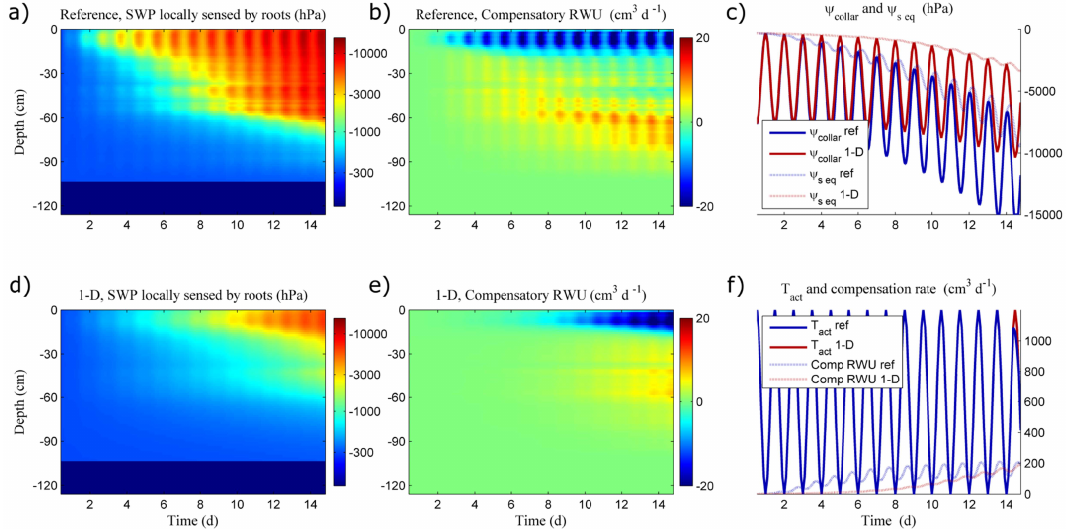
Fig. 7. Spatio-temporal distribution of (a, d) SWP locally sensed by roots and (b, e) compensatory RWU rates (spatial integration of positive terms), respectively in reference and 1-D scenarios. Temporal evolution of (c) plant collar water potential and SWP sensed by the plant, and (f) actual transpiration and compensation rates (scenario: maize, high T daily on silt loam).